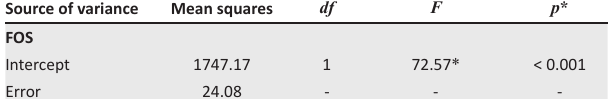
TABLE 2: Repeated analysis of variance for sense of future orientation scale. Source of variance